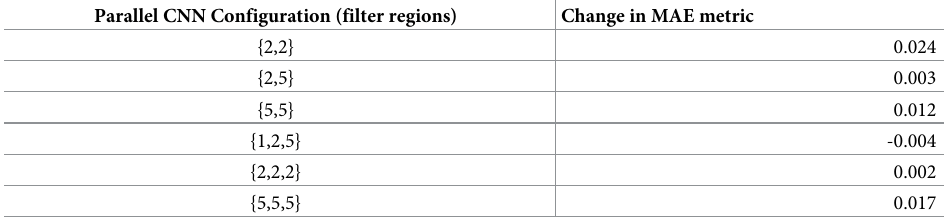
Table 4. Effect of parallel CNN models measured using change in